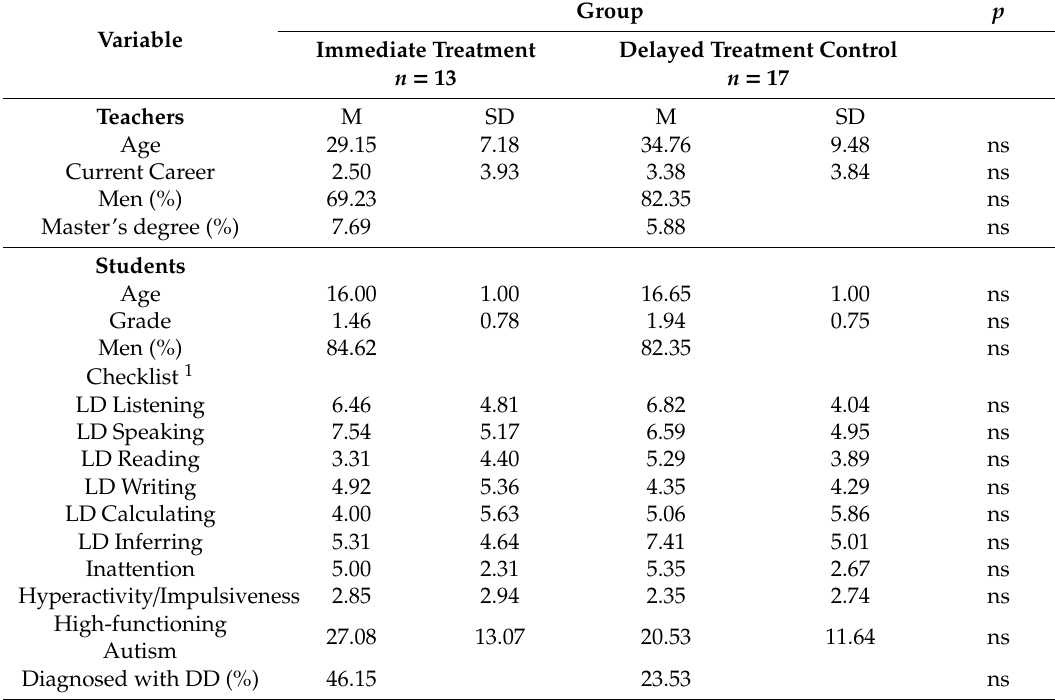
Table 3. Mean demographic and baseline variables for the immediate treatment and delayed treatment control